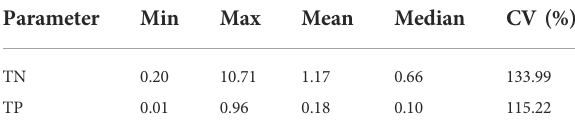
TABLE 1 Water quality analysis results of the water bodies of Changsha (mg/L).